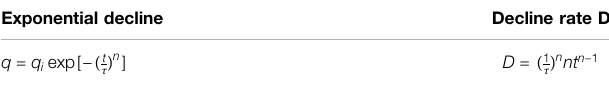
TABLE 2 | Decline-curve equations proposed by Valko and Lee